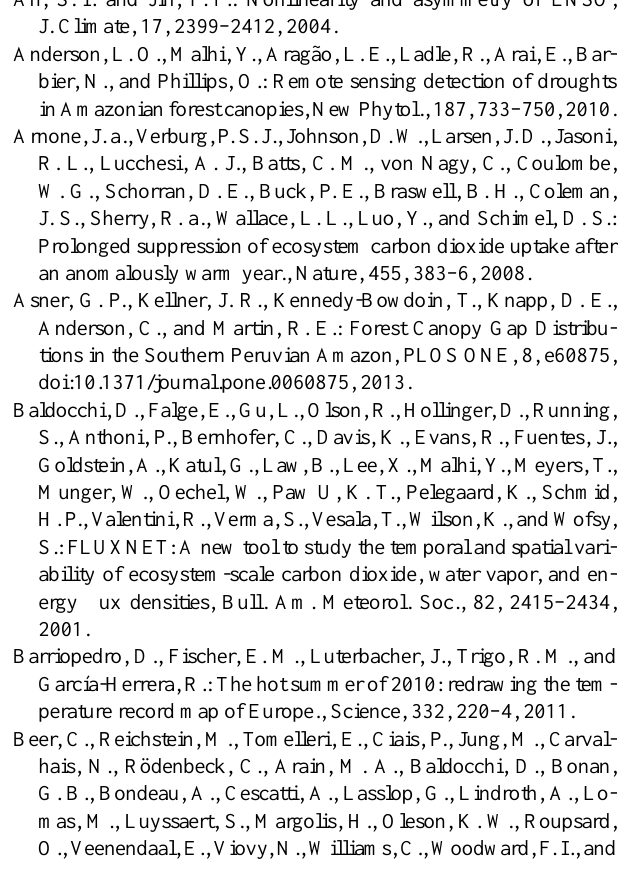
Table 1. JZ is part of the International Max Planck Research School for global Biogeochemical Cycles